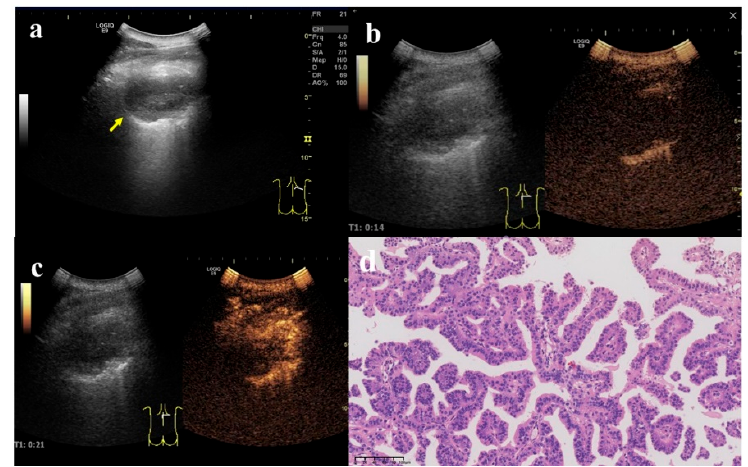
Figure 5. A 58-year-old male with a lesion occupying the deep space in the lower corner of the right shoulder armor. ( a ) Two-dimensional ultrasound showed a hypoechoic nodule, size 5.5 × 4.5 cm (arrow). At least one angle (between lesion border and thoracic wall) was obtuse. ( b ) Contrast-enhanced ultrasound showed that the enhancement time of lung tissue was 10 s and that of nodule was 14 s. ( c ) The enhancement began from the periphery to the center. The enhancement reached the peak in 30 s, and the enhancement degree was obviously uneven. ( d ) Pathologic evaluations revealed lung adenocarcinoma, mainly solid and acinar ( × 200). Table 2. Univariate analysis of ultrasound and doppler parameters.